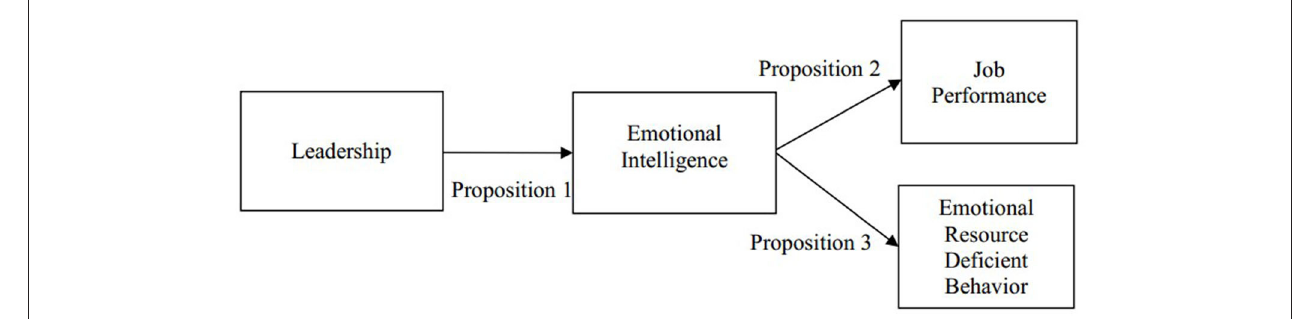
FIGURE 1 | Research